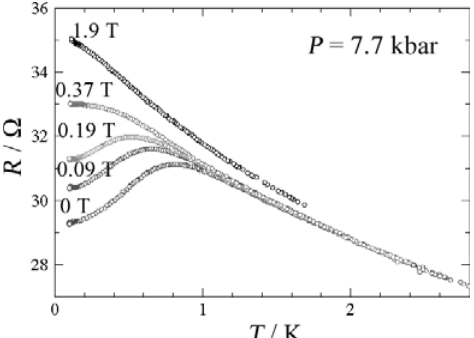
Figure 12. Temperature dependence of the resistance of TTF •[Ni(dmit) in the superconducting domain, for different applied magnetic fields ranging from 0 to 1.9 T. [Reproduced with permission from [6] J. Phys.: Condens. Matter. 2008 , 20